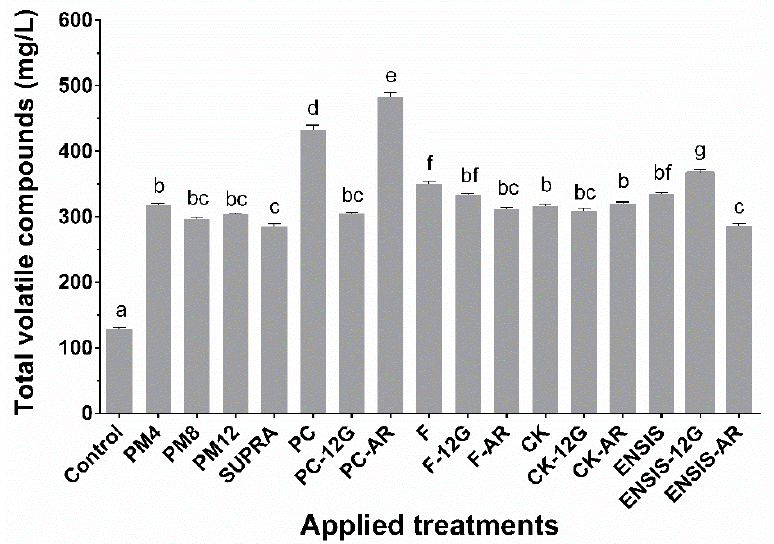
Figure 1. Total volatile compounds in Palomino fino wine samples with application of extractive and aroma-release techniques. Lowercase superscript letters show statistical significance ( p < 0.05). PM4, PM8 and PM12: pellicular maceration for 4, 8 and 12 h, respectively; SUPRA: supra-extraction wine; PC, F, CK and ENSIS: wine elaborated by different yeast strains; 12G and AR: correspond to enzymatic extracts used. PC: “pie de cuba”; F: Fermivin; CK: CK S-102; ENSIS: ENSIS-L5; 12G: Novoferm 12G; AR: Rapidase AR-2000.